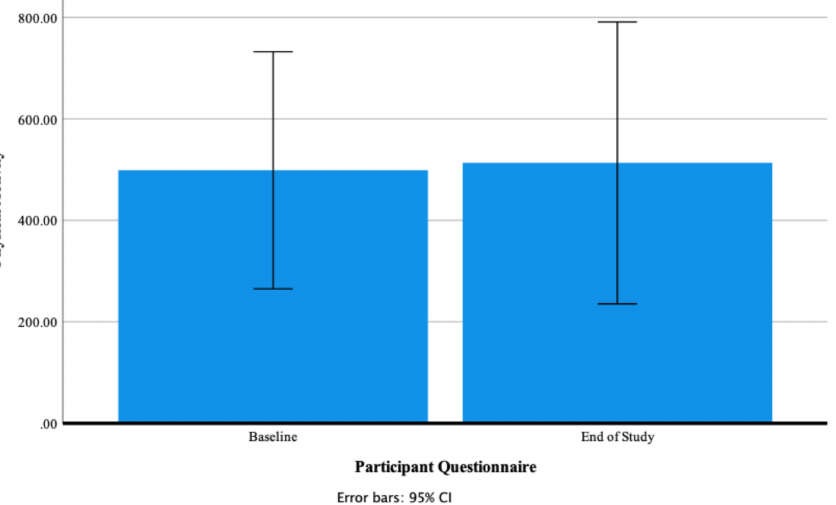
Figure 10. Participants’ self-reported mean weekly minutes of moderate- to vigorous-intensity physical activity at baseline and end of study.